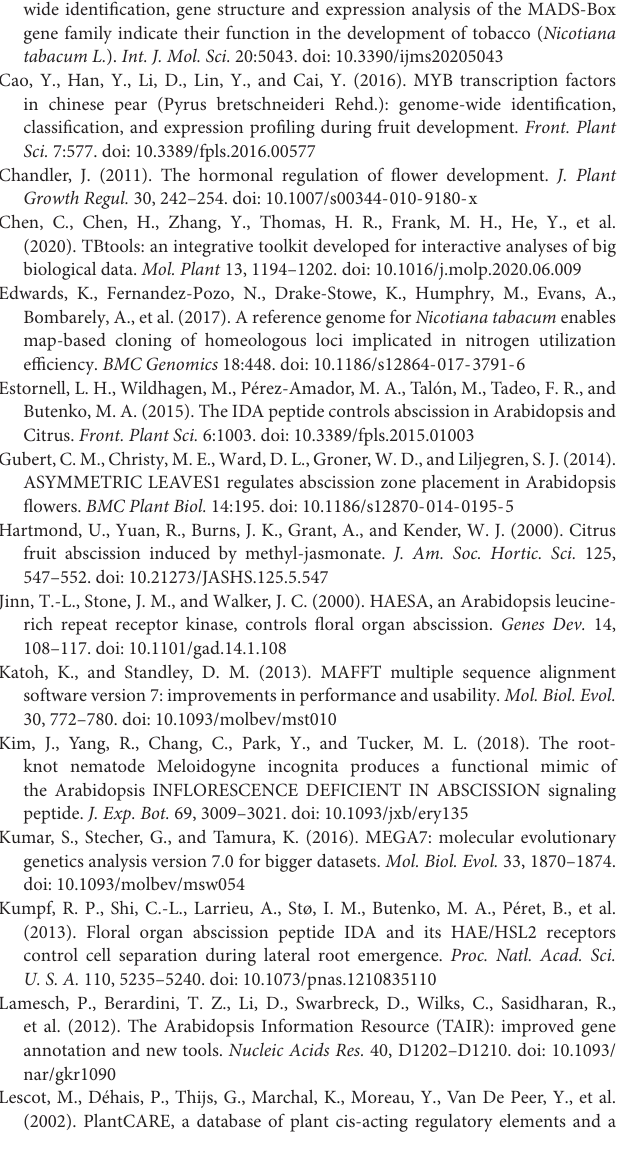
similarity is 100%, and the gray indicates that the amino acid similarity is ranged from 60 to 90%. Supplementary Figure 2 | The expression pattern of NtHAE-Like genes in selected tissues (A) and in abscission zone during the flower development (B) . Panel (A) : “R,” “S,” “L,” “ST,” and “F” mean roots, stems, leaves, shoots and flowers, respectively. Their expressions were calculated as folds relative to the expression level of the roots to confirm the tissue specificity. Panel (B) : “S1–S5” means “Stage 1 to Stage 5 of flower development.” All expression levels were calculated through the 2 − (cid:49)(cid:49) Ct method. The data were means ± SD from three independent replications. * p < 0.05, ** p < 0.01, ( t -test). Supplementary Table 1 | The qRT-PCR primers used in this study. Supplementary Table 2 | HAE-Like gene family members in